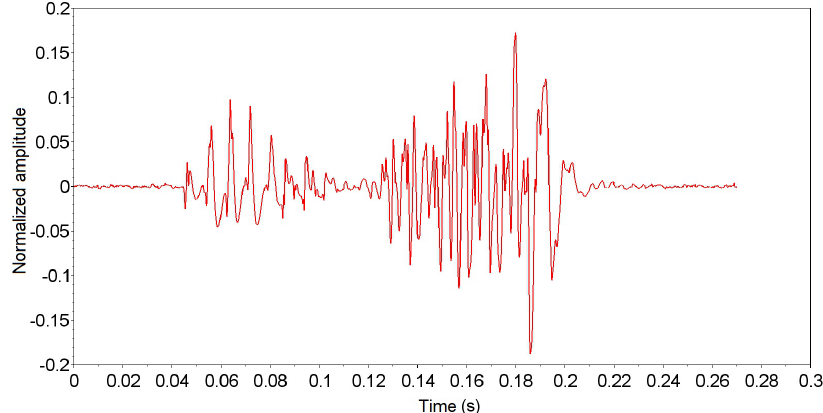
Figure 16. Anastrepha fraterculus passing event signal not classified in the standard